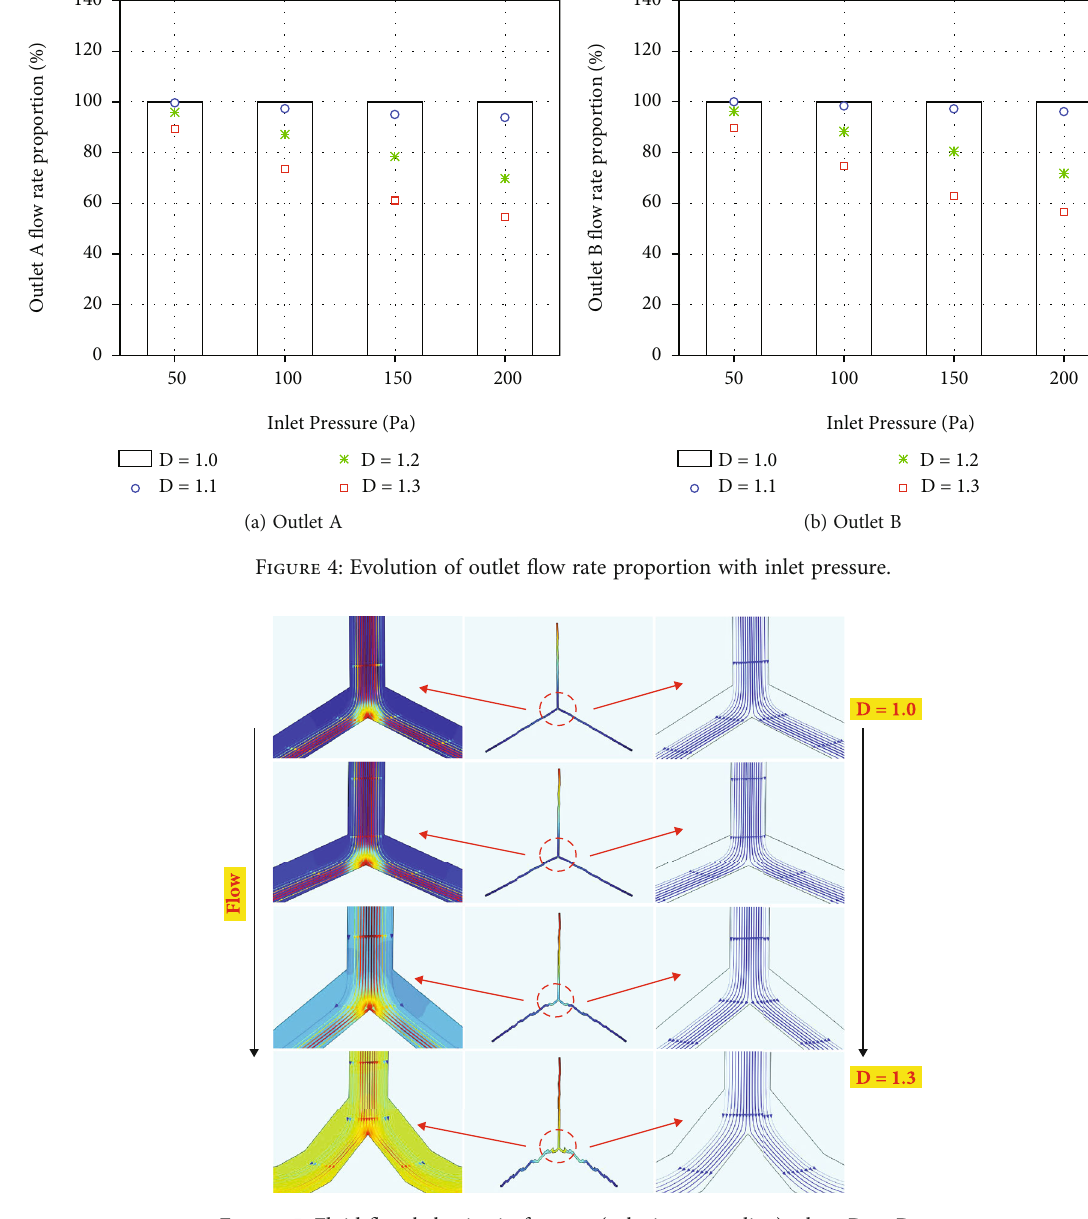
Figure 5: Fluid fl ow behavior in fracture (velocity streamline) when D